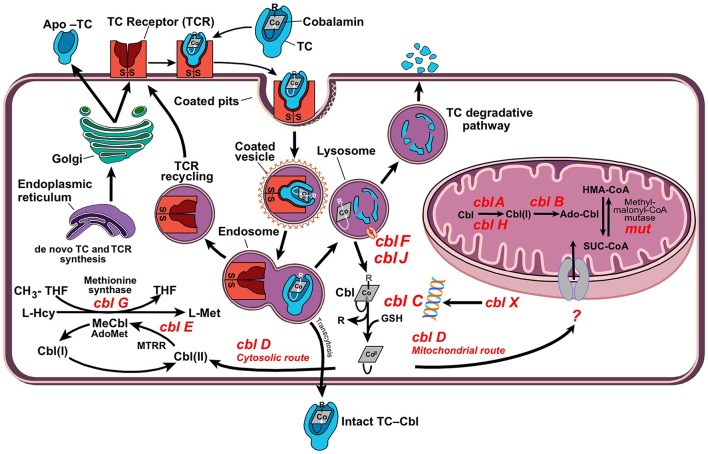
Cellular processing and trafficking of dietary vitamin B12. Cells take up holo-TC via TC-receptor-mediated endocytosis (TCR). In the lysosome, cobalamin (Cbl) is liberated and apo-transcobalamin is degraded, while the TCR is recycled back to the cell surface. Cbl exits the lysosome via transporters cblF/cblJ. In the cytosol, Cbl undergoes processing by enzyme cblC, which catalyzes removal of the upper-axial ligand (R), reduction of the cobalt center and conversion into the base-off configuration. The fate of newly processed B12 is dictated by cblC-cblD interactions, which direct the cofactor into either cytosolic methionine synthase (MS, cblG) or mitochondrial methylmalonyl-CoA mutase (MCM, mut). Nutritional and functional deficiencies of B12 lead to the inactivation of client enzymes MS and MCM with elevations of tHcy and MMA.